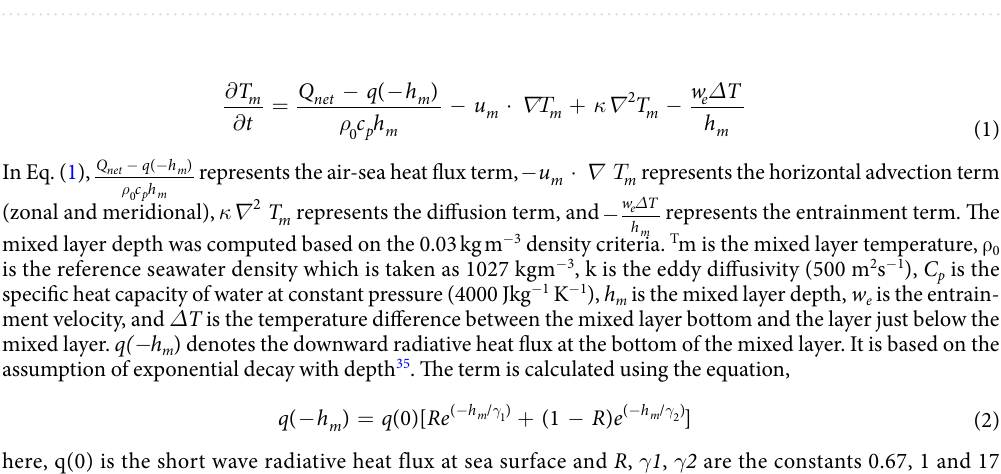
Figure 5. ( a ) Time series of monthly mean SLP, ( b ) SLP difference between the MH [45°E–100°E and 20°S–40°S] and the Indian landmass [45°E–100°E and 10°N–35°N], ( c ) Cross-equatorial winds [37.5°E–60°E and 5°S–5°N]. All trends are significant above a 95% confidence